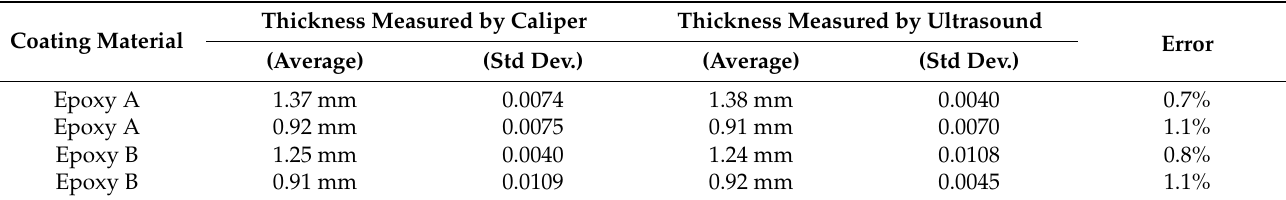
Table 2. Coating layer thickness measurements by caliper and